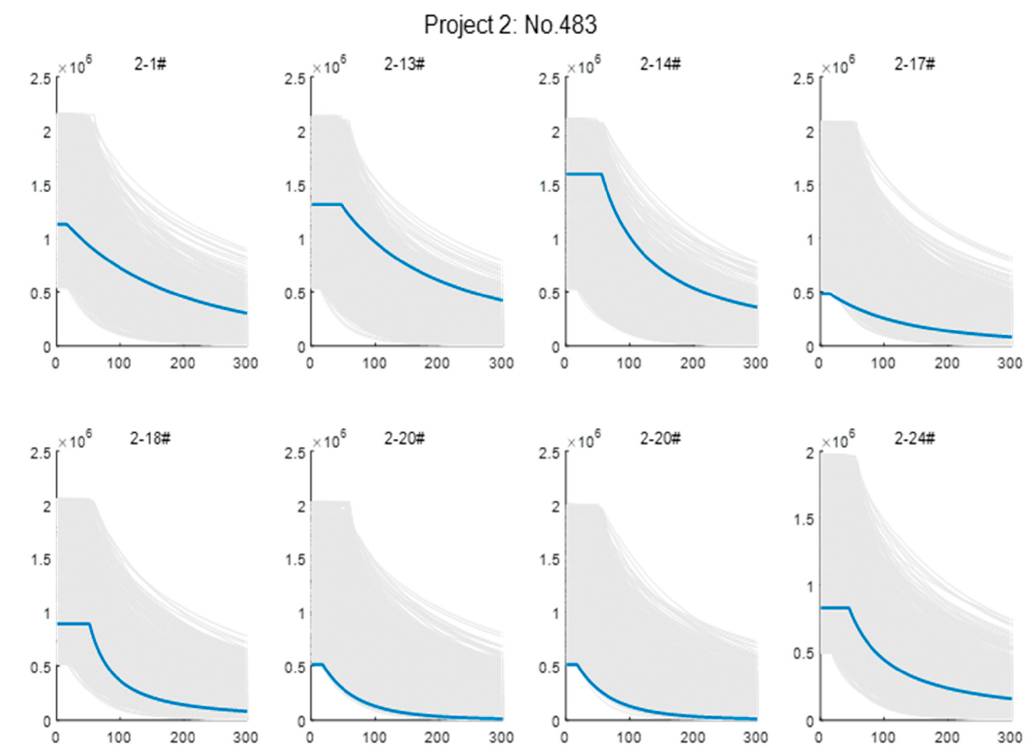
Figure 5. Production plan of project 2.